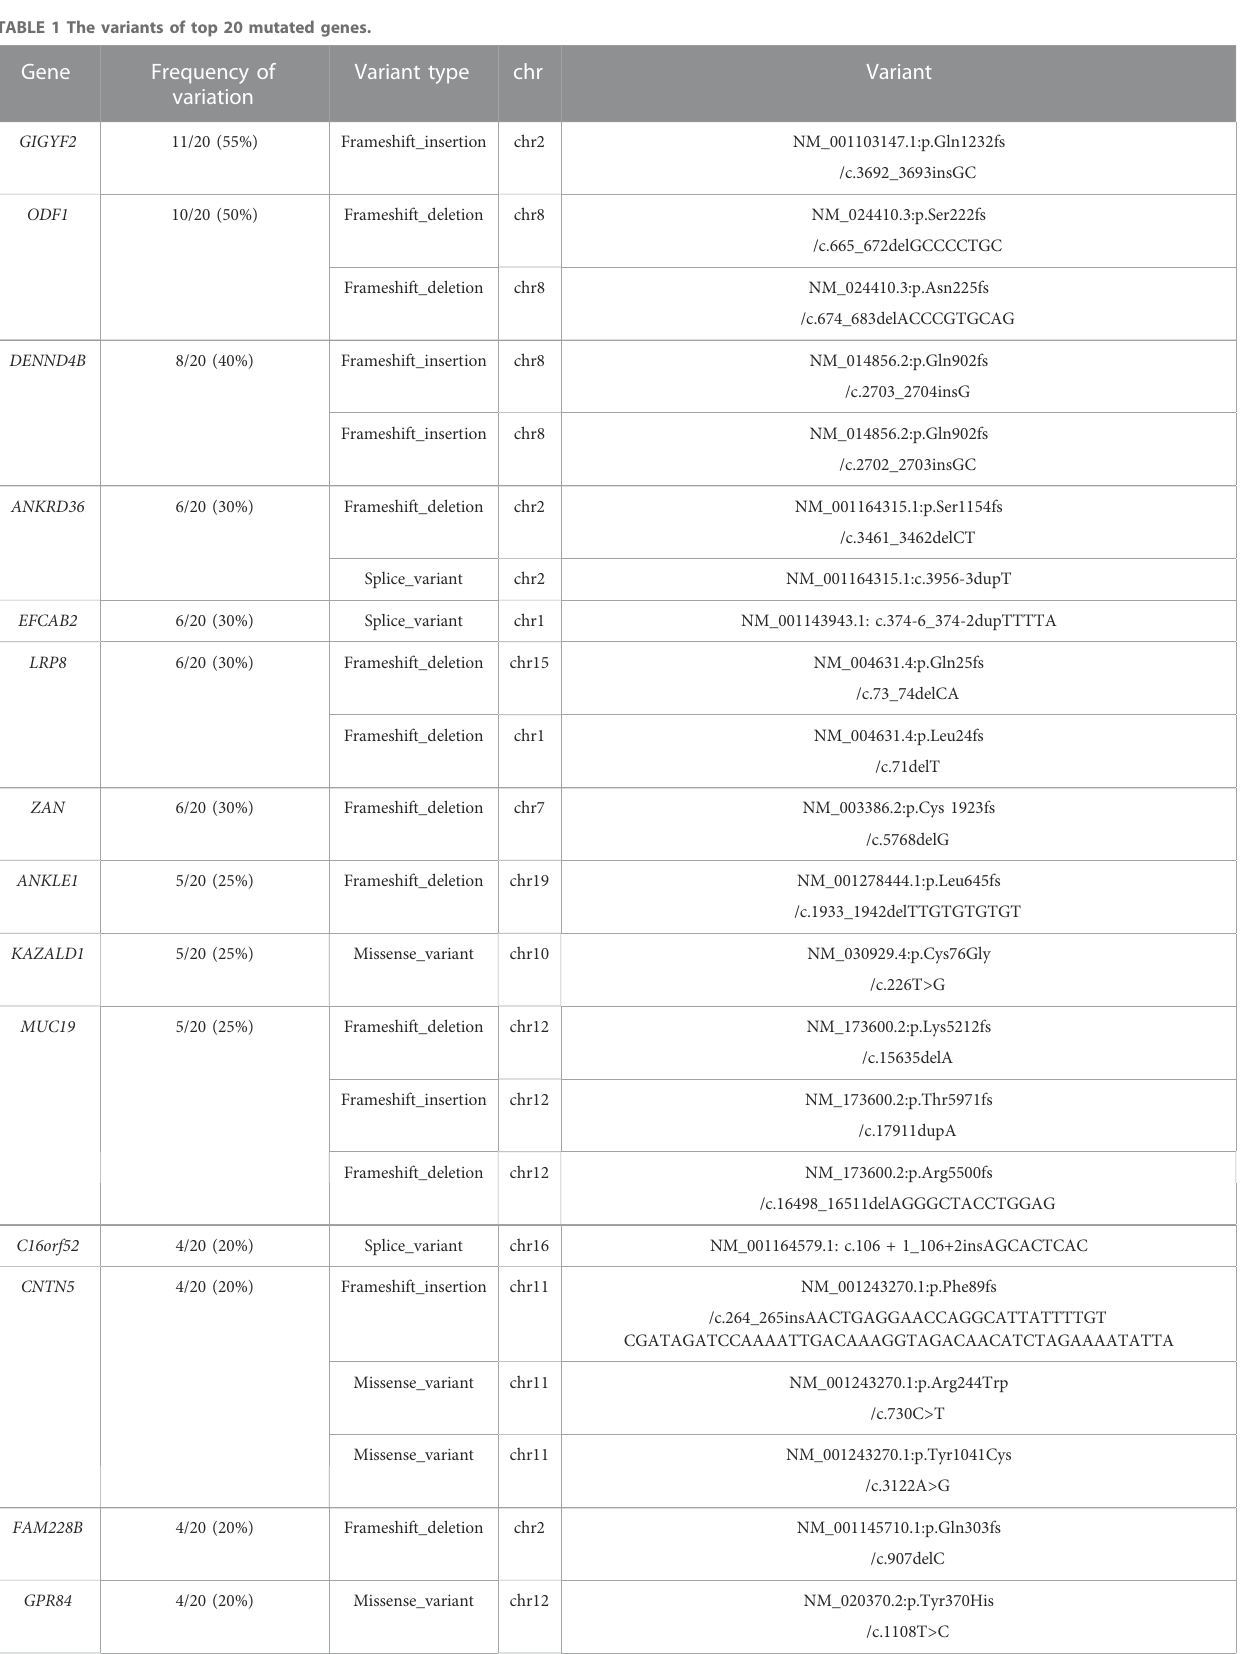
TABLE 1 The variants of top 20 mutated